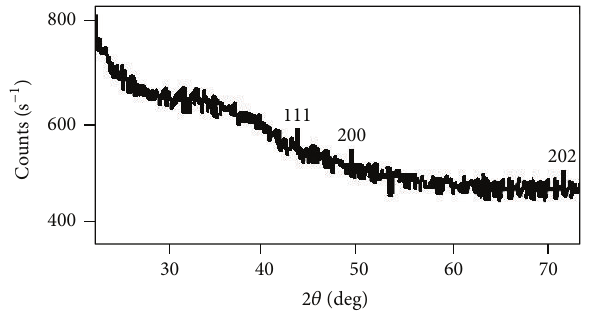
Figure 5: XRD pattern of FeNPs synthesized using Henna leaves extract.